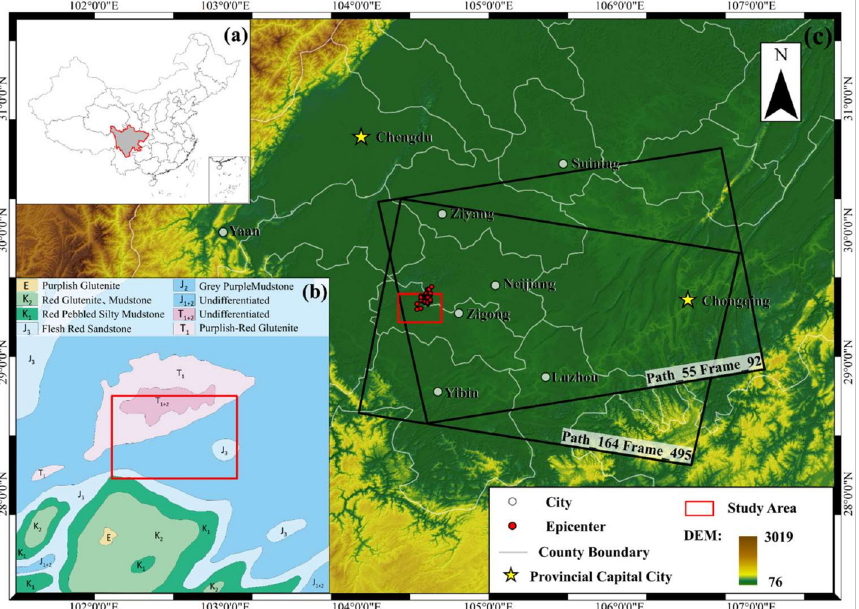
Figure 1. ( a ) Location of the study area in China; ( b ) Geological map of the study area (Modified from [21]); ( c ) map of the study area and the image coverage, superposed on the ALOS DEM.